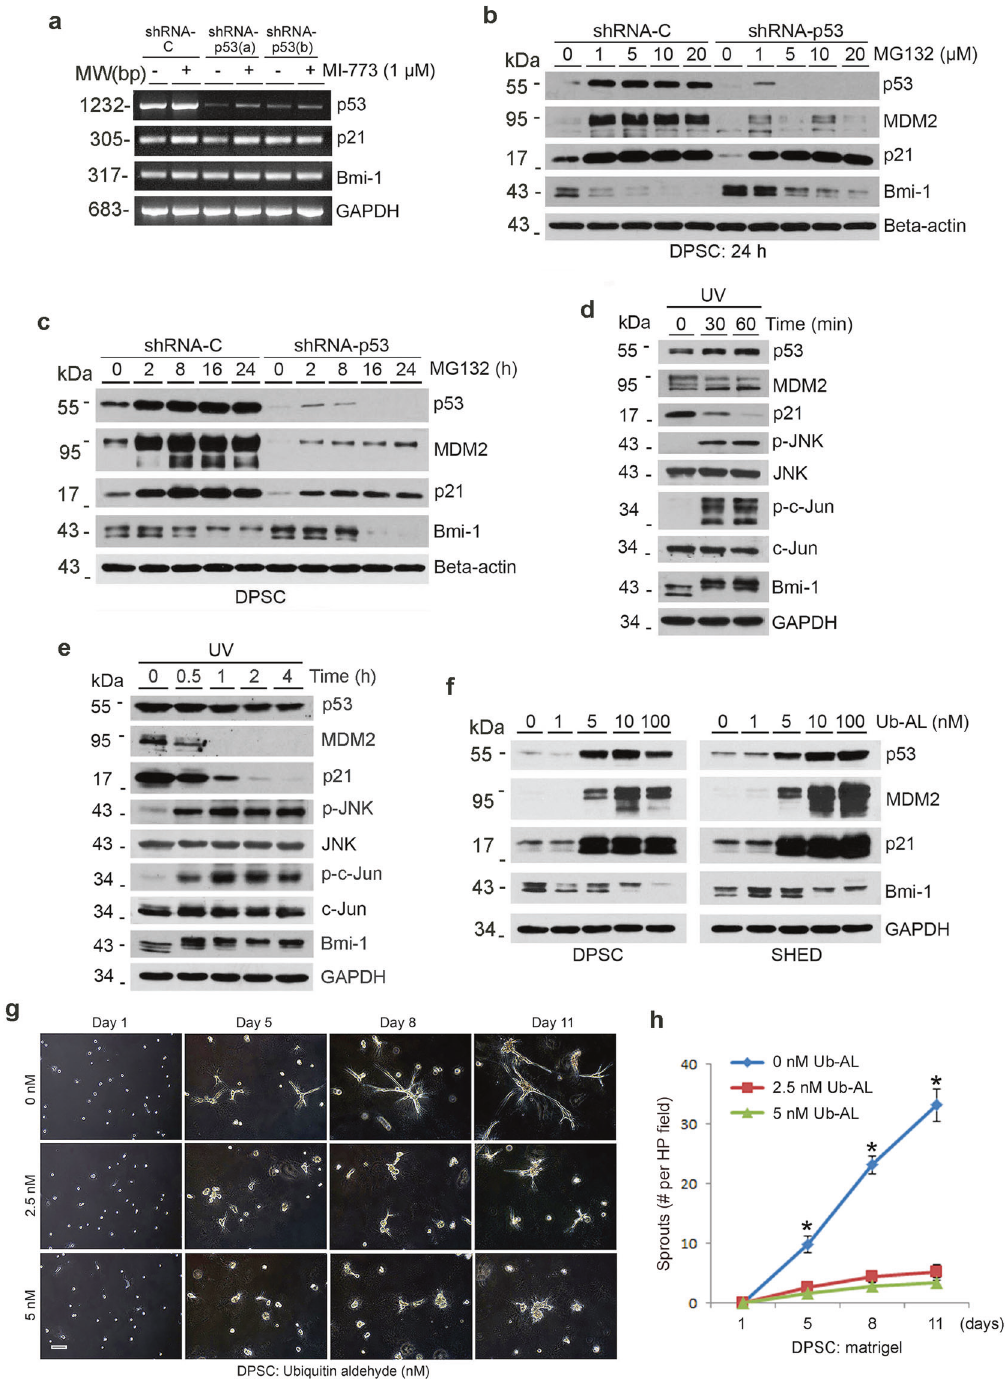
Fig. 6 Ubiquitin/proteasome activity regulates Bmi-1 and vasculogenic differentiation of pulp stem cells. a shRNA-transduced DPSC were treated with 1 µM MI-773 for 24 h, RT-PCR for p53, p21, and Bmi-1. b , c shRNA-transduced DPSC were cultured with 0 – 20 µM proteasome inhibitor MG132 for 24 h ( b ), or 5 µM MG132 for indicated time points ( c ), western blots for p53, MDM2, p21, and Bmi-1. d , e SHED ( d ) and DPSC ( e ) were exposed to ultraviolet (UV) for 1 min, then cultured for time points, western blots were performed for p53, MDM2, p21, p-JNK, JNK, p-c-Jun, c-Jun, and Bmi-1. f DPSC and SHED were treated with 0 – 100 nM ubiquitin aldehyde for 24 h, western blots were performed for p53, MDM2, p21, and Bmi-1. g , h 1 × 10 4 DPSC were seeded in growth factor-reduced matrigel and cultured with EGM2 in the presence of 0 – 2.5 nM ubiquitin aldehyde for different time points. g photographs of sprout in DPSC. Scale bar: 100 µm. h Graph depicting the number of sprouts formed in g . Asterisk indicates p < 0.001, as determined by one-way ANOVA followed by a post hoc test (Tukey ’ s